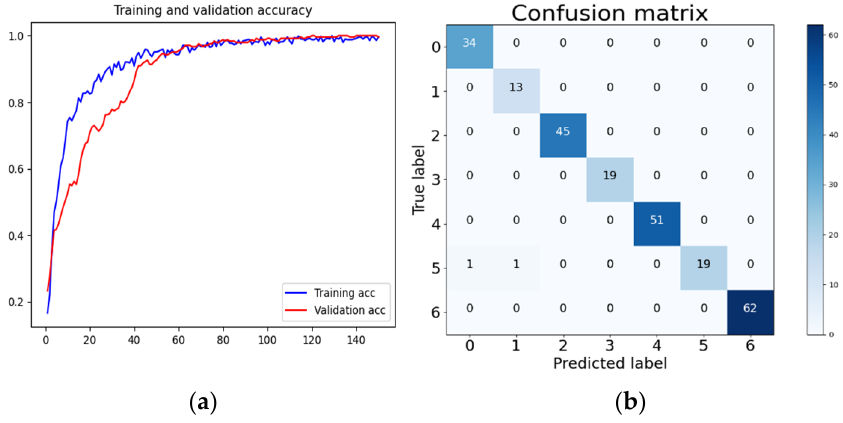
Figure 10. Validation results of the CK+ dataset. ( a ) acc curve; ( b ) confusion matrix.